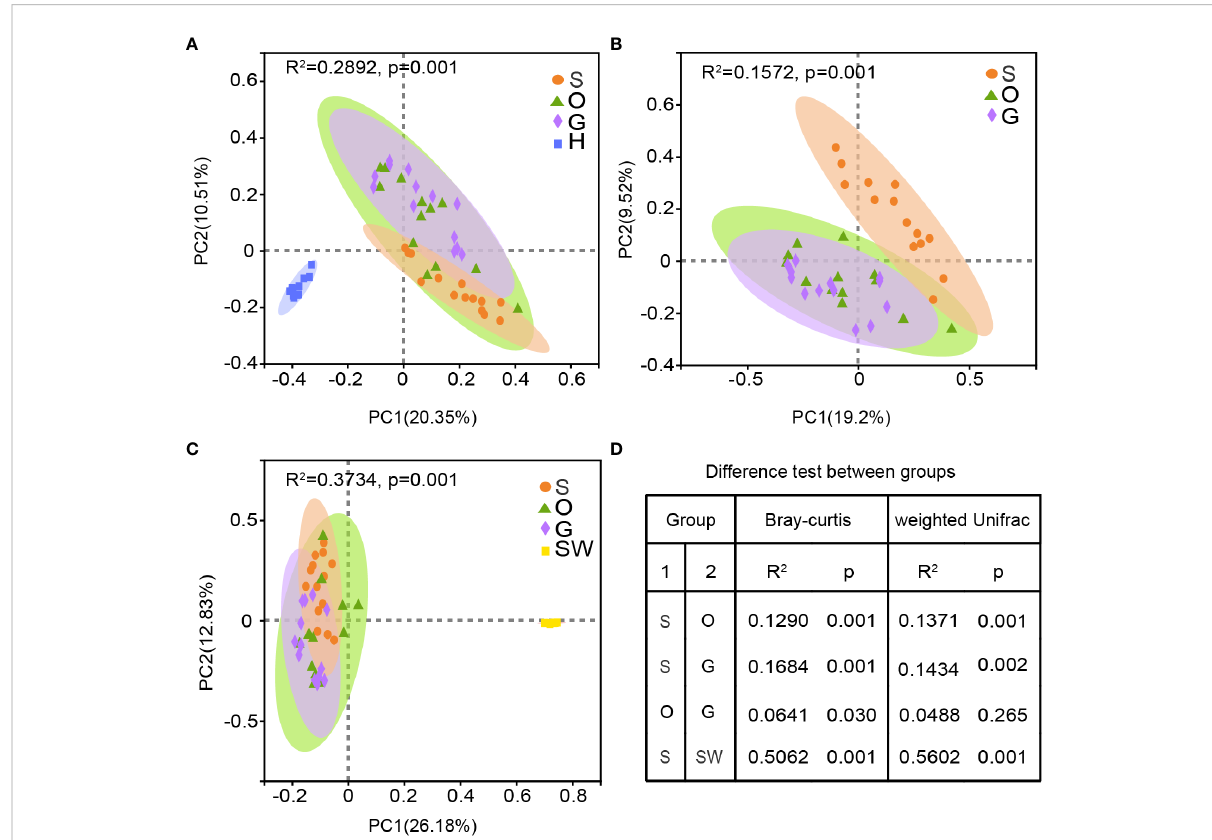
FIGURE 2 Beta diversity of bacterial communities in four body sites of tunas and seawater. (A) PCoA analysis of all microbiome across the external and hindgut. (B) PCoA analysis of external mucus microbiome. (C) PCoA analysis of external mucus microbiome and seawater. (D) Pairwise comparisons of beta diversity distances between groups are calculated by the Bray-Curtis metrics and weighted Unifrac metrics. S, skin; O, oral; G, gill; H, hindgut; SW,